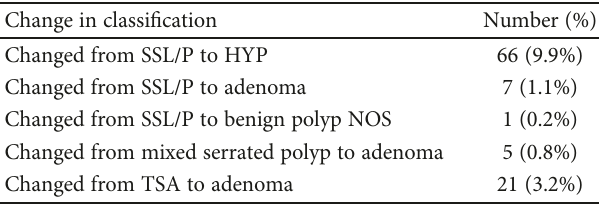
Table 2: Reclassi fi cation of serrated polyps (SSL/Ps and